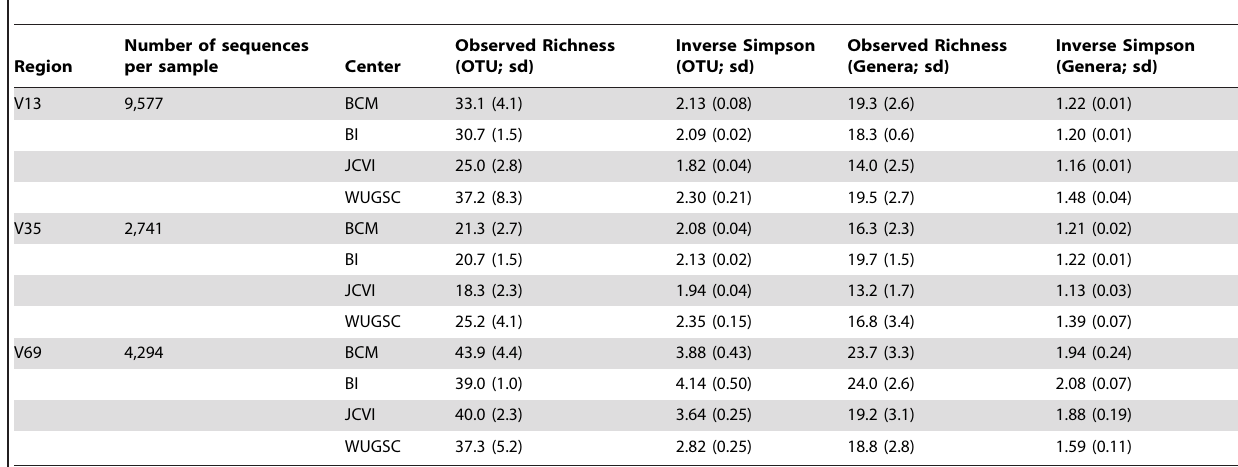
Table 4. The richness and diversity of OTUs and genera identified in the control stool sample sequence collections for each region and sequencing